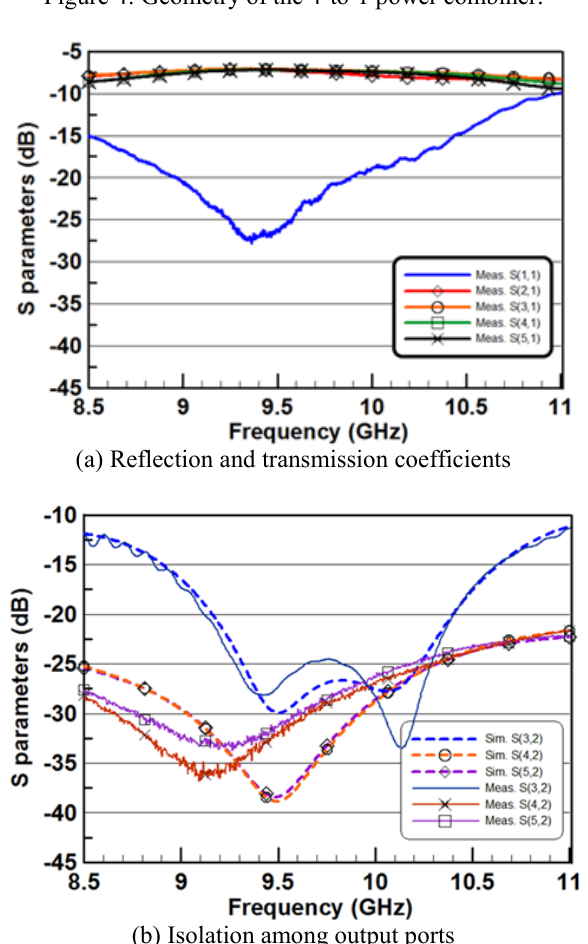
Figure 4: Geometry of the 4-to-1 power combiner.